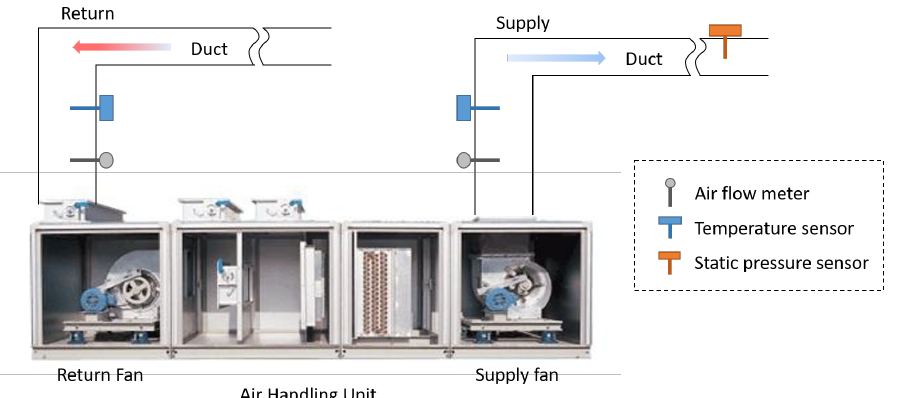
Figure 4. Air Handling Unit (AHU) and the connected components in the